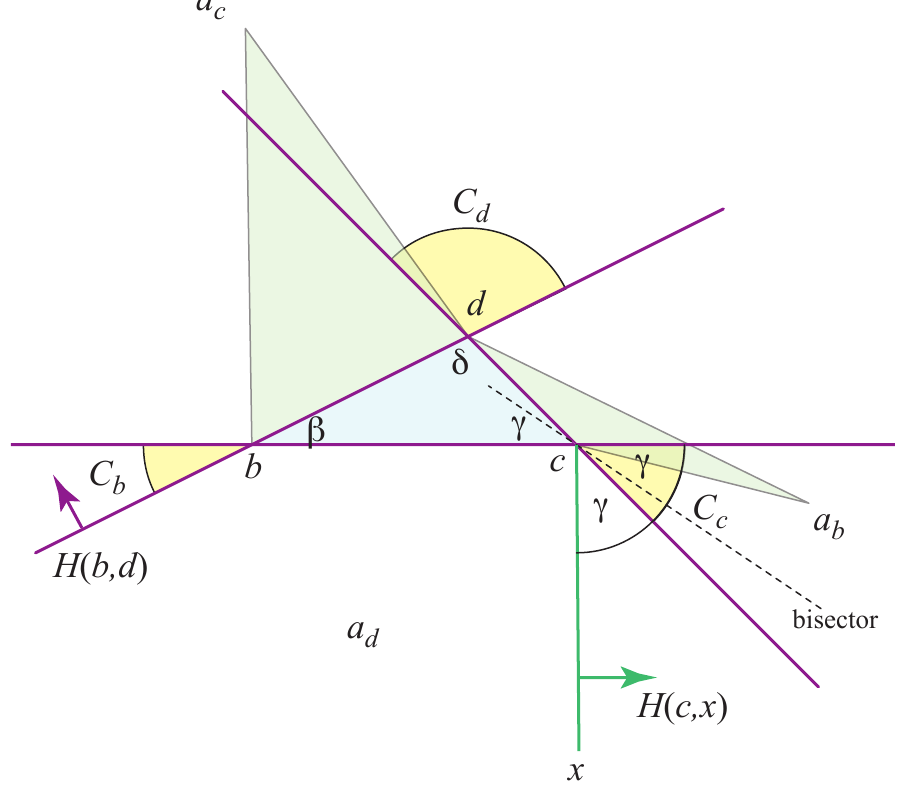
Figure 11. Case 2: a d must lie in H ( c , x ) for the bisector of a d and a b to penetrate (cid:52) bcd at c